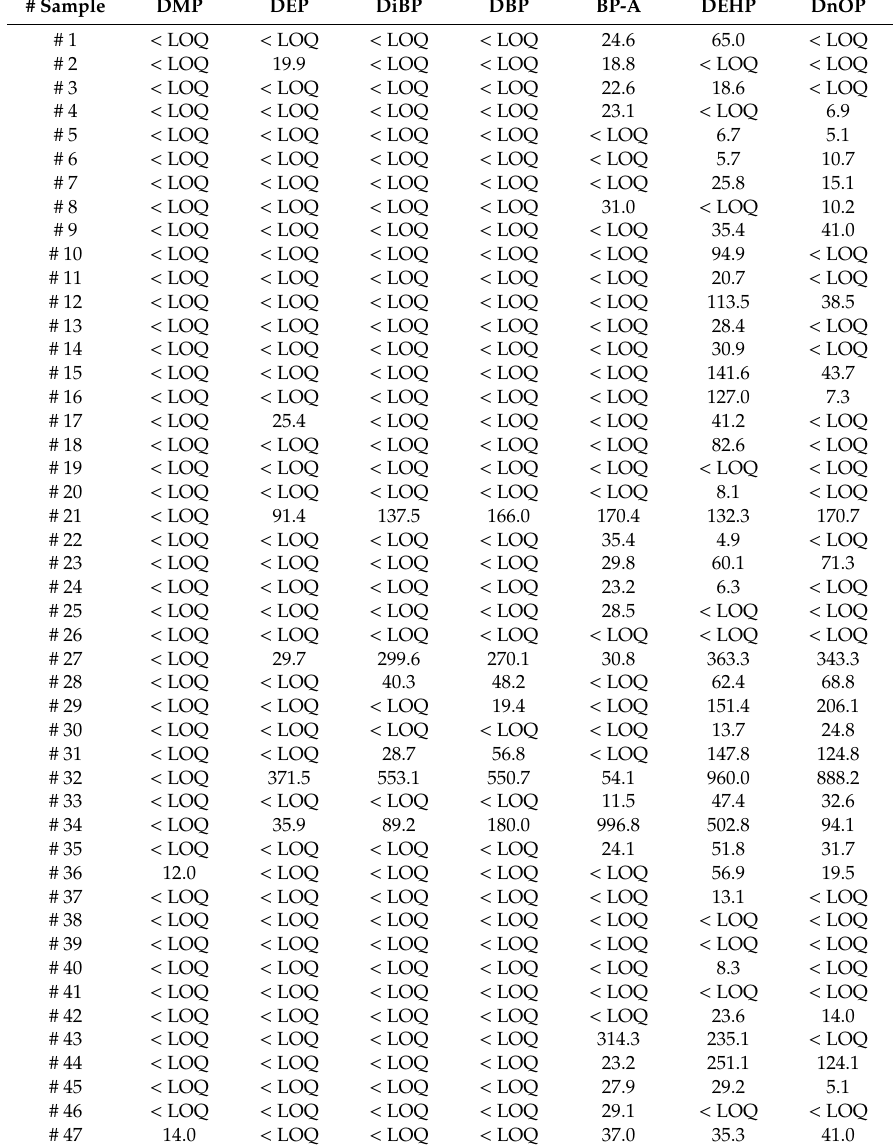
Table 4. Levels (ng g − 1 ) of DMP, DEP, DiBP, DBP, BP-A, DEHP and DnOP in the 47 nectar honey samples analyzed. For abbreviations see Table 1. For LOQs see Table